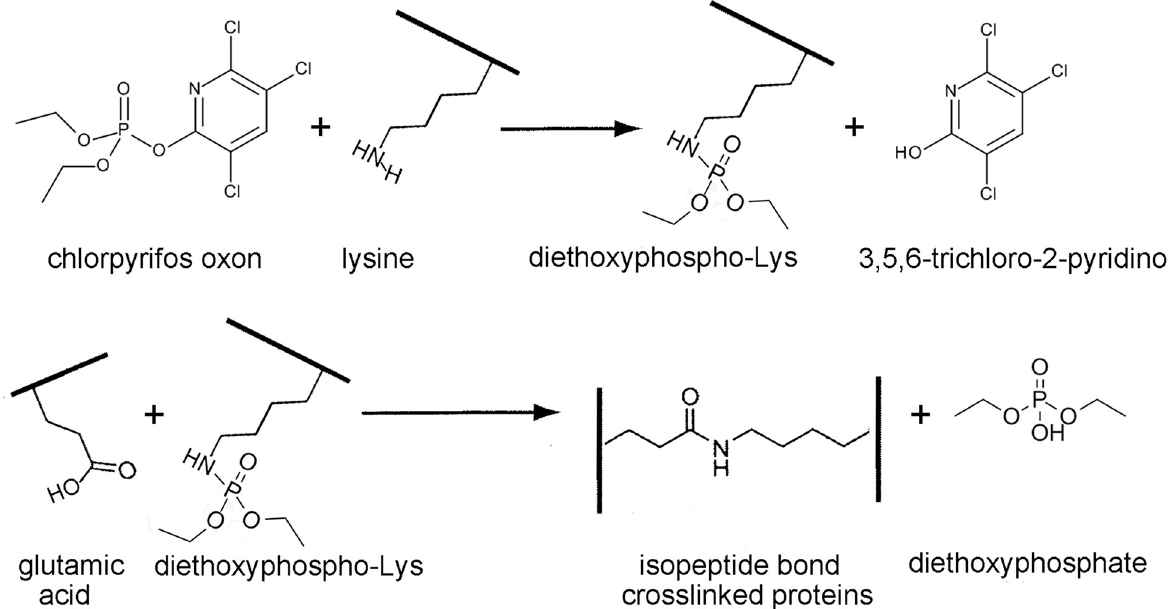
Fig 8. Chemically induced protein crosslinking is initiated when chlorpyrifos oxon makes a covalent bond with lysine to make diethoxyphospho-lysine. The activated diethoxyphospho-lysine reacts with a nearby glutamic acid or aspartic acid to make an isopeptide bond with release of diethoxyphosphate. The KE and KD crosslinks are resistant to trypsin.